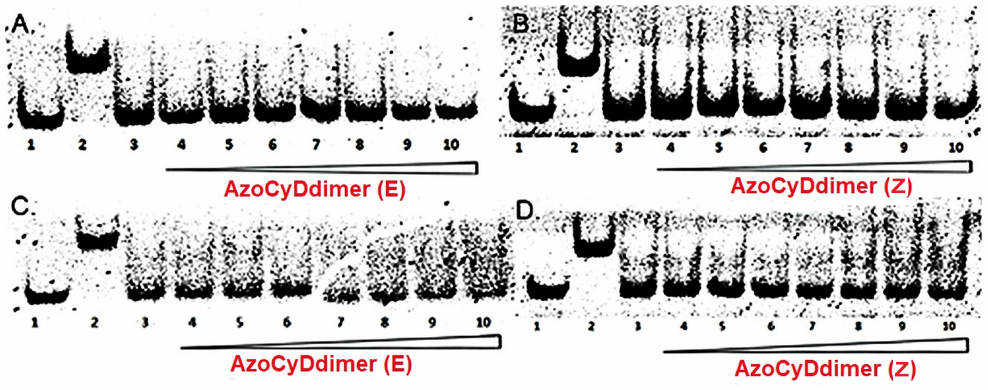
Figure 4. EMSA analysis of DNA binding of Ad26 peptide in the presence and absence of azoCyDdimer. ( A ) Lanes 1–10: 50 nM AP1 ( (cid:48) 5-cggATGA c TCATtttttttc-3 (cid:48) ); lane 2: 300 nM SS52; lanes 3–10: 200 nM Ad26 and 0, 0.5, 1, 2, 5, 20, 50, 100 equivalents azoCyDdimer (E). ( B ) Lanes 1–10: 50 nM AP1 ( (cid:48) 5-cggATGA c TCATtttttttc-3 (cid:48) ); lane 2: 300 nM SS52; lanes 3–10: 200 nM Ad26 and 0, 0.5, 1, 2, 5, 20, 50, 100 equivalents azoCyDdimer (Z). ( C ) Lanes 1–10: 50 nM CRE ( (cid:48) 5-cggATGA cg TCATttttttt-3 (cid:48) ); lane 2: 300 nM SS52; lanes 3–10: 200 nM Ad26 and 0, 0.5, 1, 2, 5, 20, 50, 100 equivalents azoCyDdimer (E). ( D ) Lanes 1–10: 50 nM CRE ( (cid:48) 5-cggATGA cg TCATtttttttc-3 (cid:48) ); lane 2: 300 nM SS52; lanes 3–10: 200 nM Ad26 and 0, 0.5, 1, 2, 5, 20, 50, 100 equivalents azoCyDdimer (Z). DNA was detected by fluorescent staining with